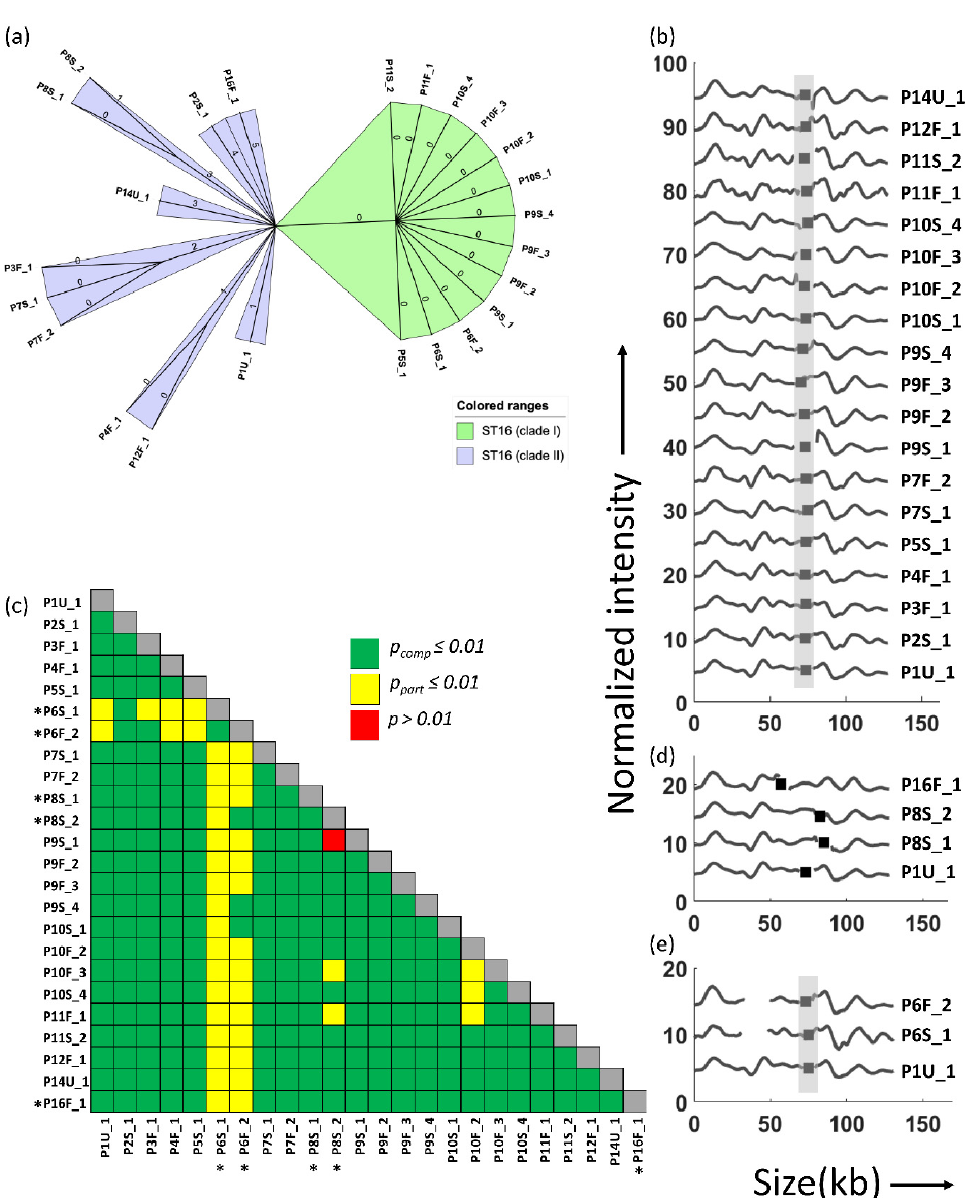
Figure 3. ( a ) Minimum spanning tree (grape tree) of all ST16 isolates based on cgMLST. The numbers on the solid black lines correspond to the number of alleles that differ between each isolate. ( b ) Barcodes of identical plasmids from ST16 isolates, stretched to 128 kb. The x-axis shows the length of the plasmids in kb and the y-axis is the normalized intensity in arbitrary units, where the intensity plot of each isolate is shifted five units vertically for clarity. ( c ) Similarity matrix of the plasmids from the ST16 isolates. Identical barcodes when stretched using the same size of 128 kb are considered as complete matches ( p comp ≤ 0.01) and are labeled green; identical barcodes when stretched using actual sizes measured by the ODM experiments are considered as partial matches ( p part ≤ 0.01) and are labeled yellow; p > 0.01 when stretched using similar lengths or measured lengths are considered “no match” are labeled red. Isolates with plasmids different from the common ST16 plasmid in 3b are denoted by a *. ( d ) ST16 isolates with barcodes identical to the common isolates, but with shifted gene site. P8S_1 and P8S_2 ( p comp ≤ 0.01) with ~10 kb shift in gene site in comparison to P1U_1 and P16F_1 with ~15 kb shift in gene site compared to P1U_1. ( e ) Isolates P6S_1 and P6F_2 with plasmids shorter by 12 kb and 7 kb compared to the average length of the common ST16 plasmids. Black squares and gray shades represent the location of the bla NDM-1 gene in ( b , d , e ).